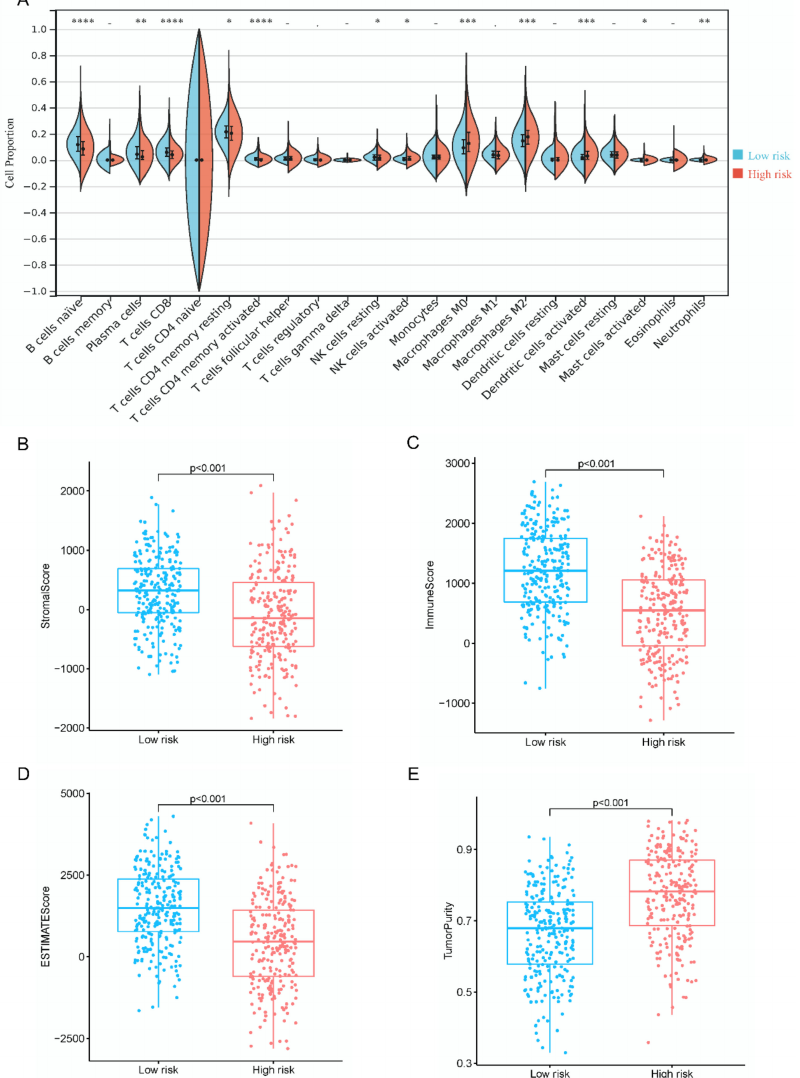
Figure 5. Immune microenvironment in the whole TCGA–LUAD set. Comparison of ( A ) 22 immune cell proportion, ( B ) stromal score, ( C ) immune score, ( D ) ESTIMATE score, and ( E ) tumor purity. Note: **** means p < 0.0001. *** means p < 0.001. ** means p < 0.01. * means p < 0.05. - means no